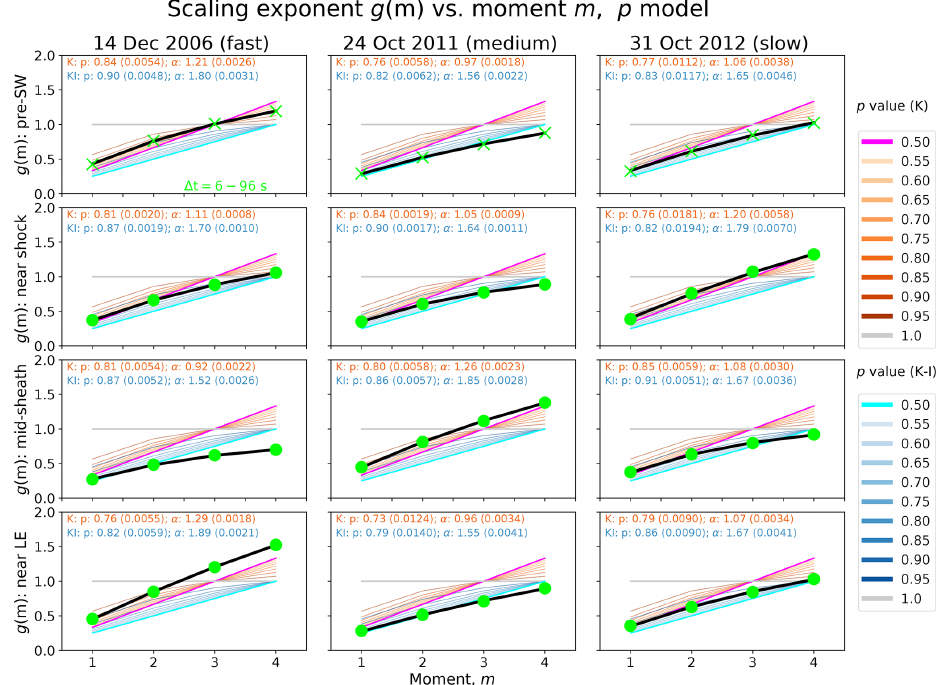
Figure 6. The dots and crosses show the scaling exponent g(m) for the structure function (cid:104)| B(t + (cid:49)t) − B(t) | m (cid:105) as a function of moment m ( m is set to range from 1 to 4) for the preceding solar wind and three subregions of the sheath. The orange and blue curves show the results for the standard p model, with p ranging from 0 . 5 to 1 in steps of 0 . 05 for the Kolmogorov’s (K) and Kraichnan–Iroshinikov (K–I) forms, respectively. The non-intermittent cases ( p = 0 . 5) are shown in pink (K) and cyan (K–I), while the grey horizontal curve gives the maximum intermittency case ( p = 1). The bright green dots show the results calculated for timescales (cid:49)t = 6–96 s, corresponding to the inertial range. The thick black line shows the least square fits for the extended p model. The values show the values of p and α parameters for the Kolmogorov’s (orange) and Kraichnan–Iroshinikov (blue) forms, with standard deviation errors in